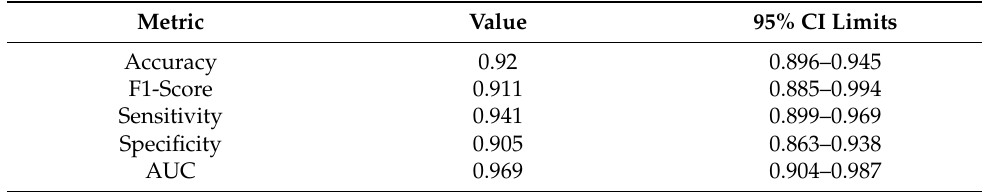
Table 3. Metrics for classification of perforated AAp.